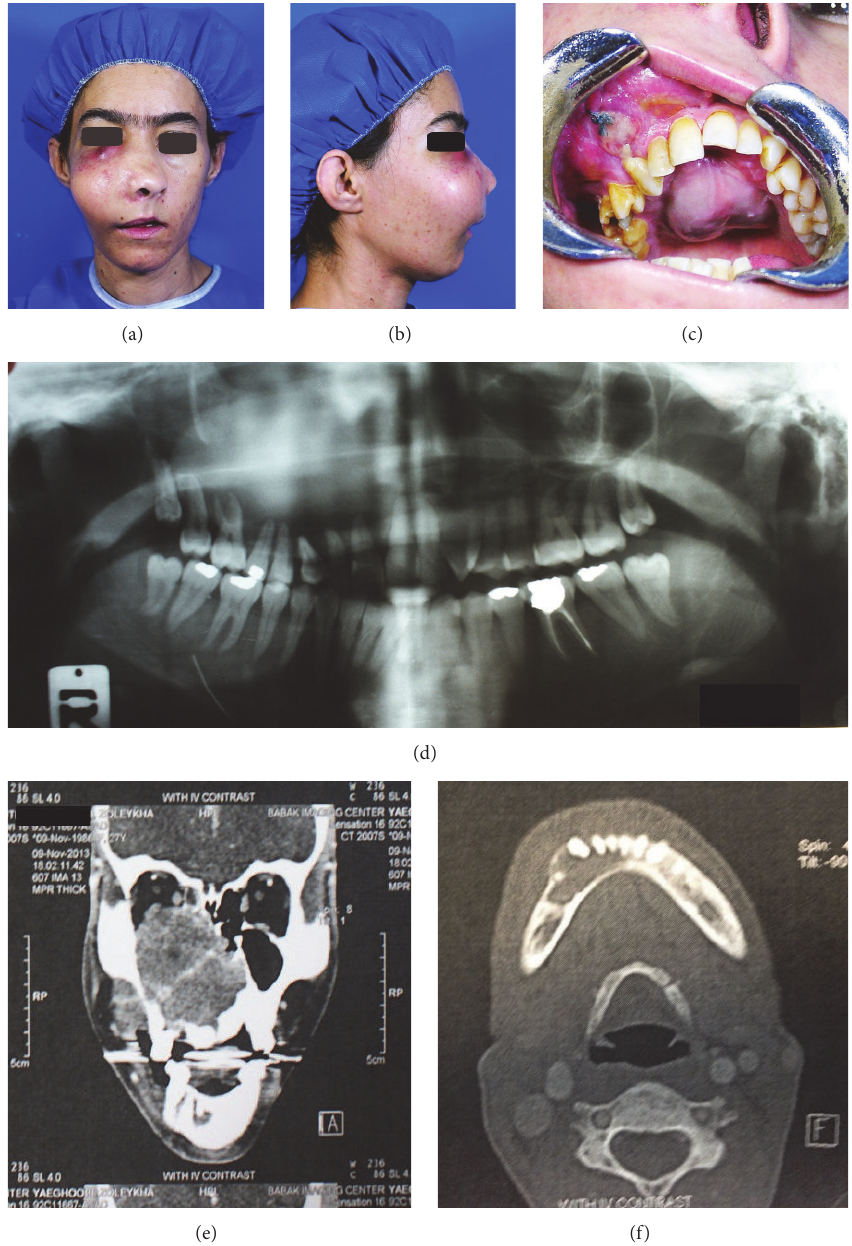
Figure 2: After 6 months, preoperative (a, b) extraoral frontal and lateral photography were carried out. (c) Intraoral photography. (d) Panoramic view. (e) Coronal contrast enhanced CT scan image. (f) Axial contrast enhanced CT scan